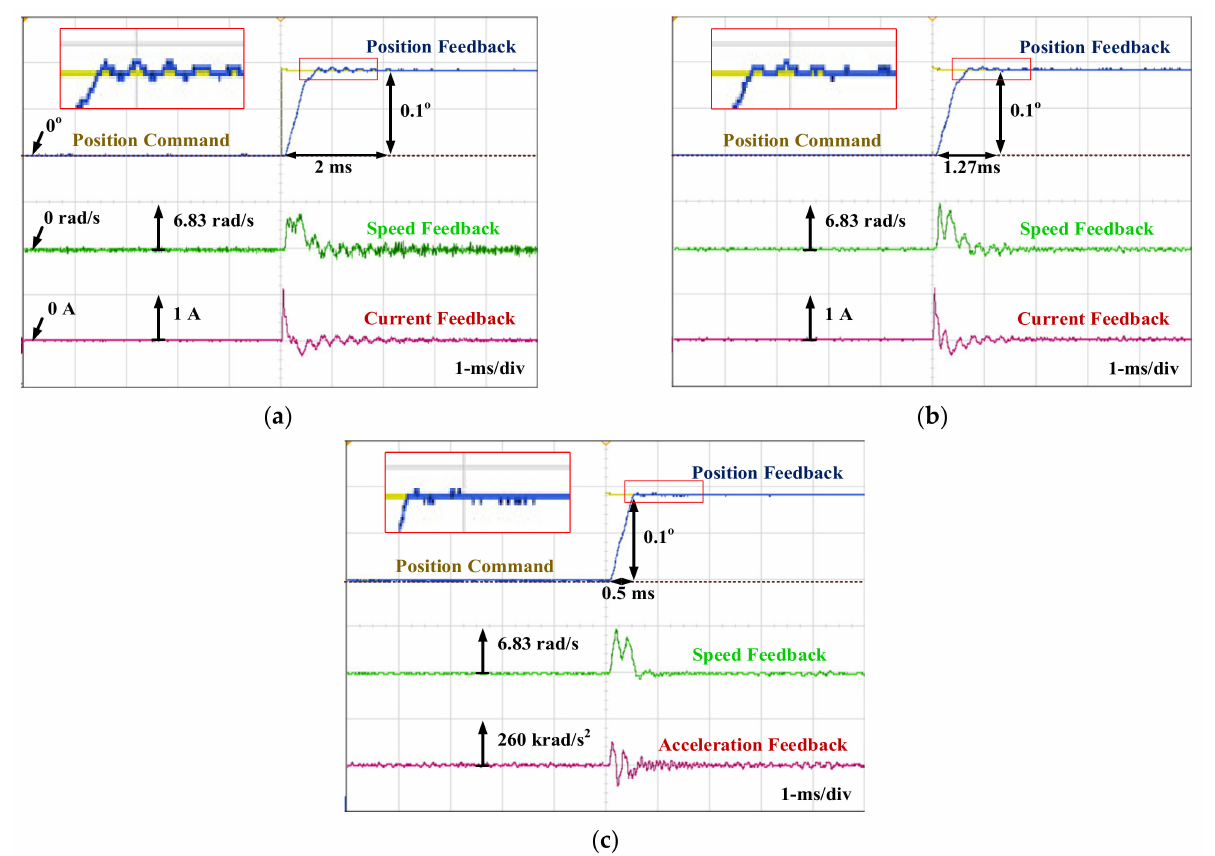
Figure 20. Comparison of position step control performance: ( a ) conventional motion control with direct speed estimation; ( b ) motion control with proposed speed estimation; and ( c ) speed estimation plus proposed acceleration control (0.64 g · cm 2 mirror